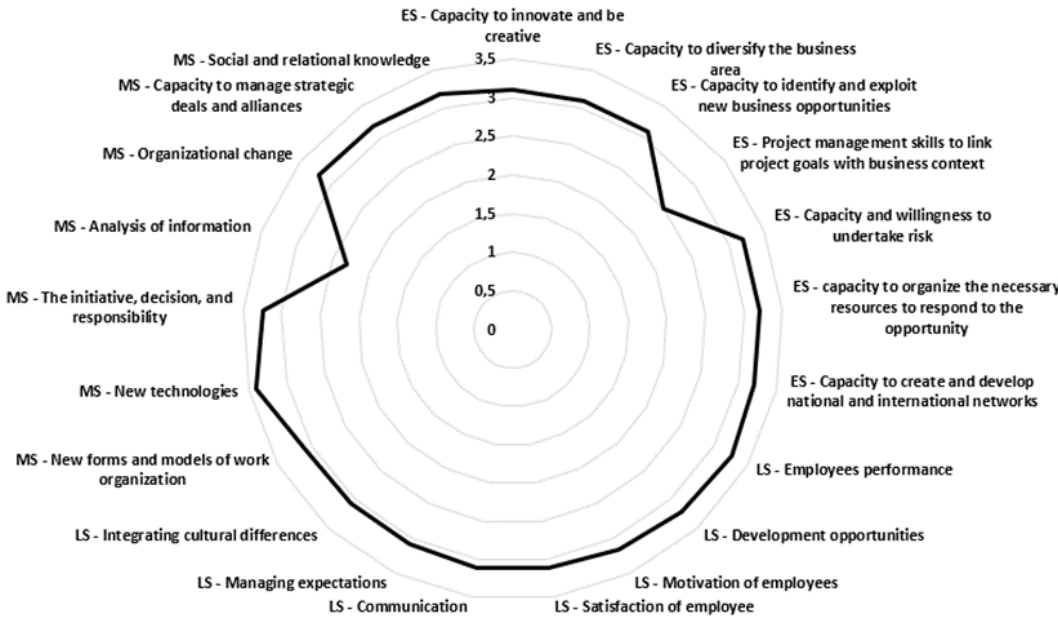
Figure 1. Perceived Skills Development for Teams Leading—Students. Legend: ES: Entrepreneurship